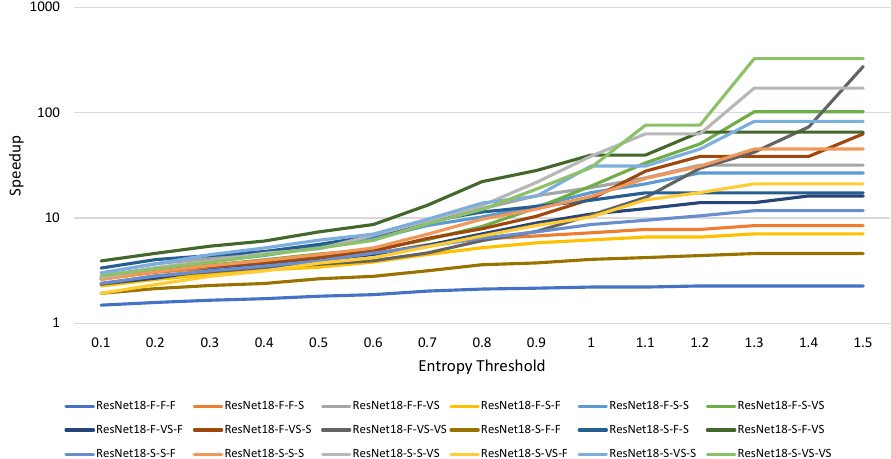
Figure 4. Accuracy of the dual model for different combinations of a small model with ResNet50. The small models in the graphic are all variants of ResNet18 described above restricted to the reduced repetition pattern of ResNet18.